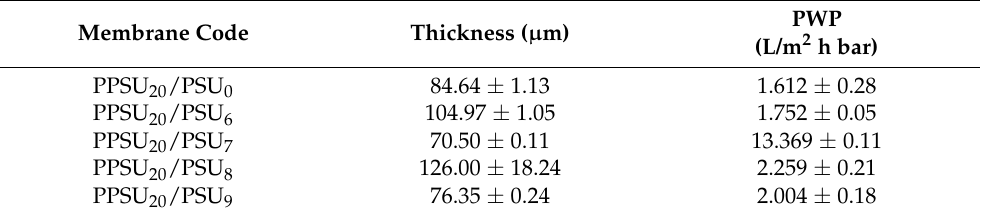
Table 2. Effect of addition of different concentrations of PES on thickness, and water permeability of the PPSU